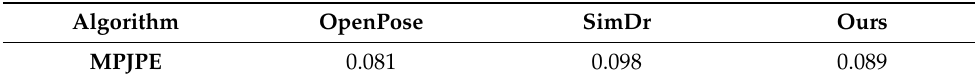
Table 4. The mean per joint position error of different